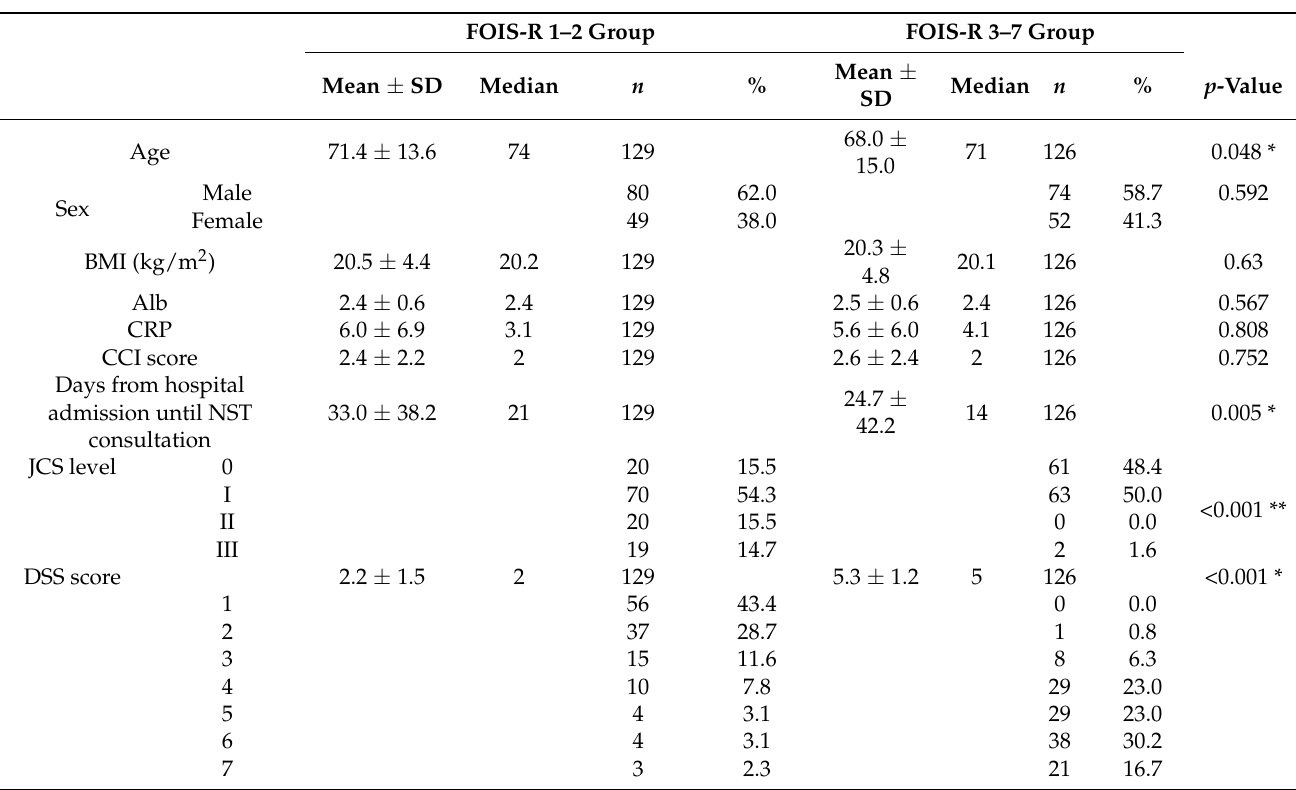
Table 2. Comparison of participants’ basic information and oral outcomes between the intravenous/enteral nutrition group (FOIS-R of 1–2) and the oral intake group (FOIS-R of